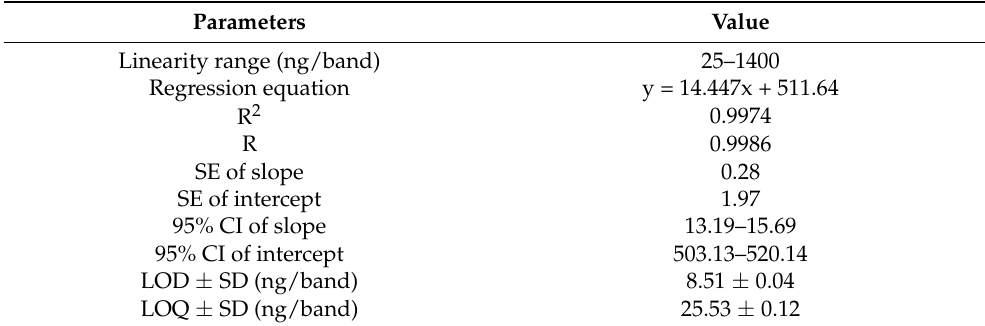
Table 2. Findings for the linearity of flufenamic acid (FFA) for the greener high-performance thin-layer chromatography (HPTLC) assay (mean ± SD; n = 6).